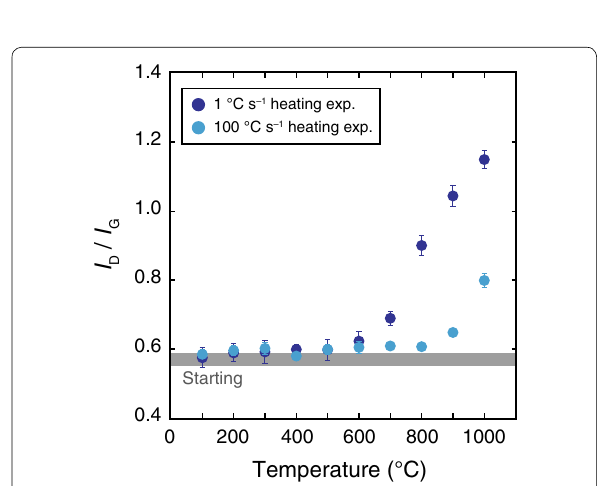
Fig. 4 Temperature dependence of the I D / I G ratios of the analyzed CM. Bars show standard deviations. exp .